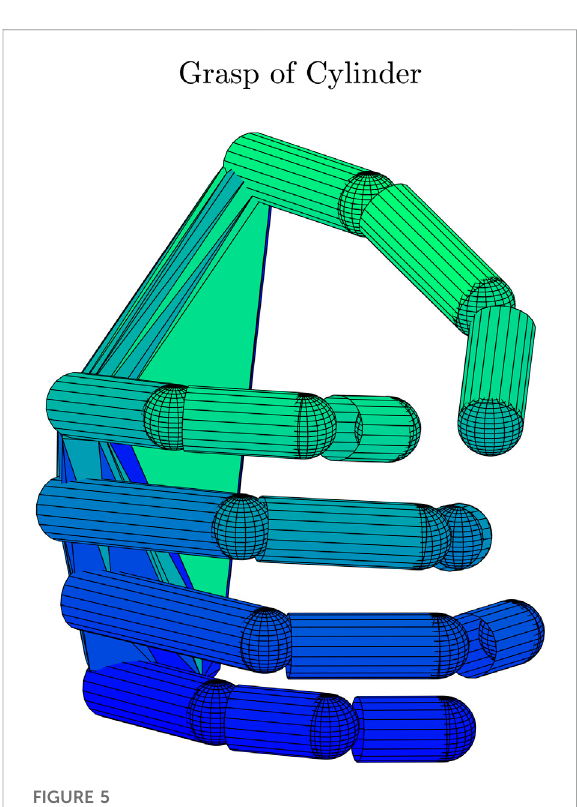
FIGURE 5 21 DoFs virtual hand that reproduces the static